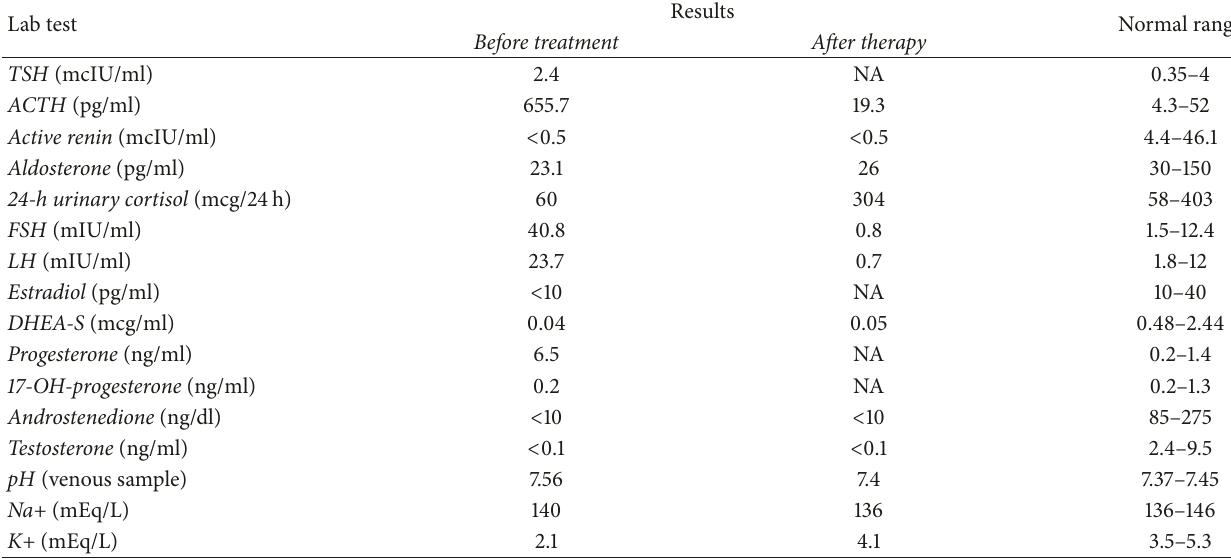
Table 1: Results of biochemical and endocrine tests in the patient reported, before and after the administration of estradiol and glucocorticoid therapy.